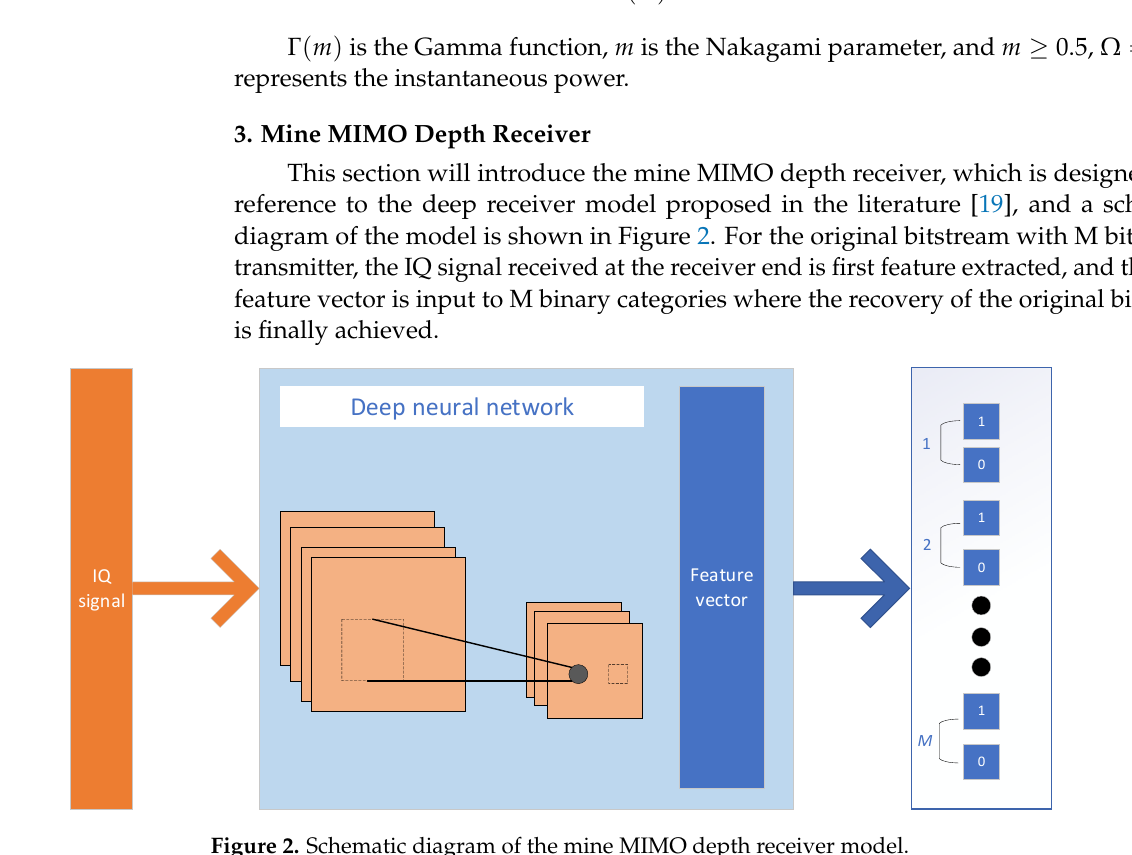
Figure 2. Schematic diagram of the mine MIMO depth receiver